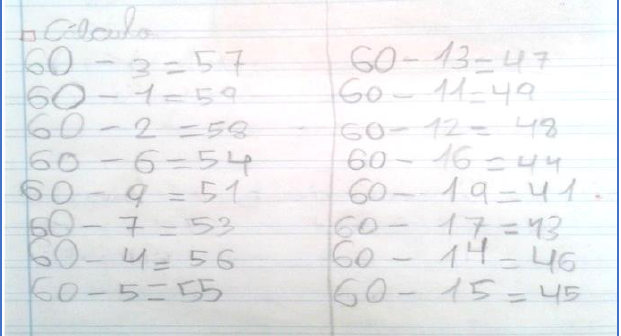
Figure 17. Example of arithmetic patterns.